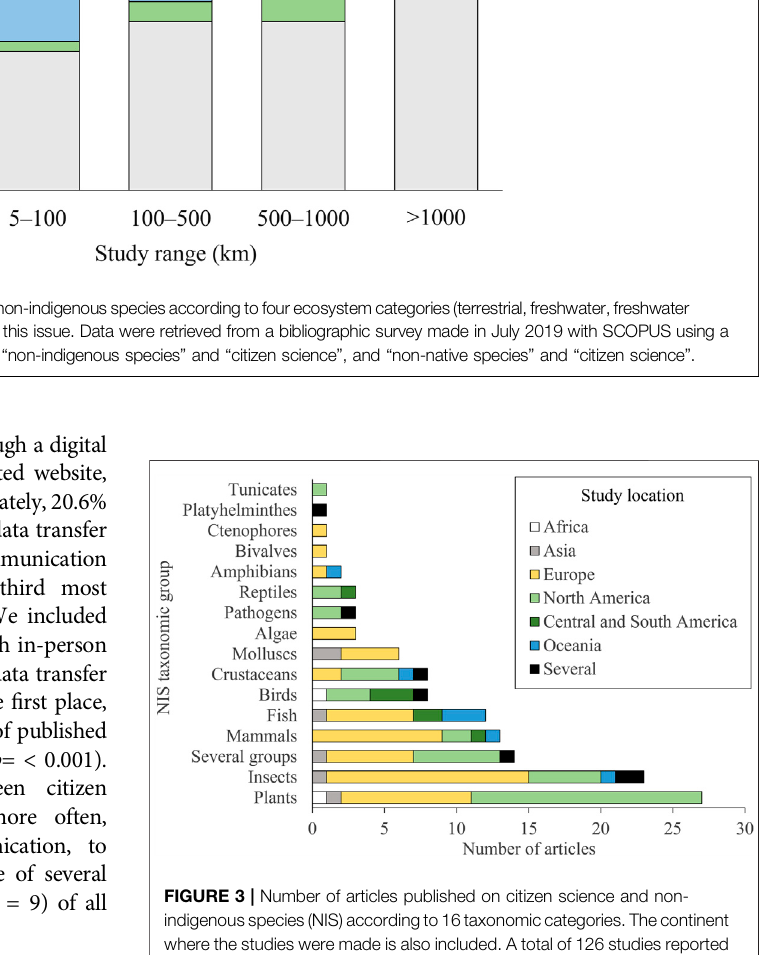
Frontiers in Environmental Science |